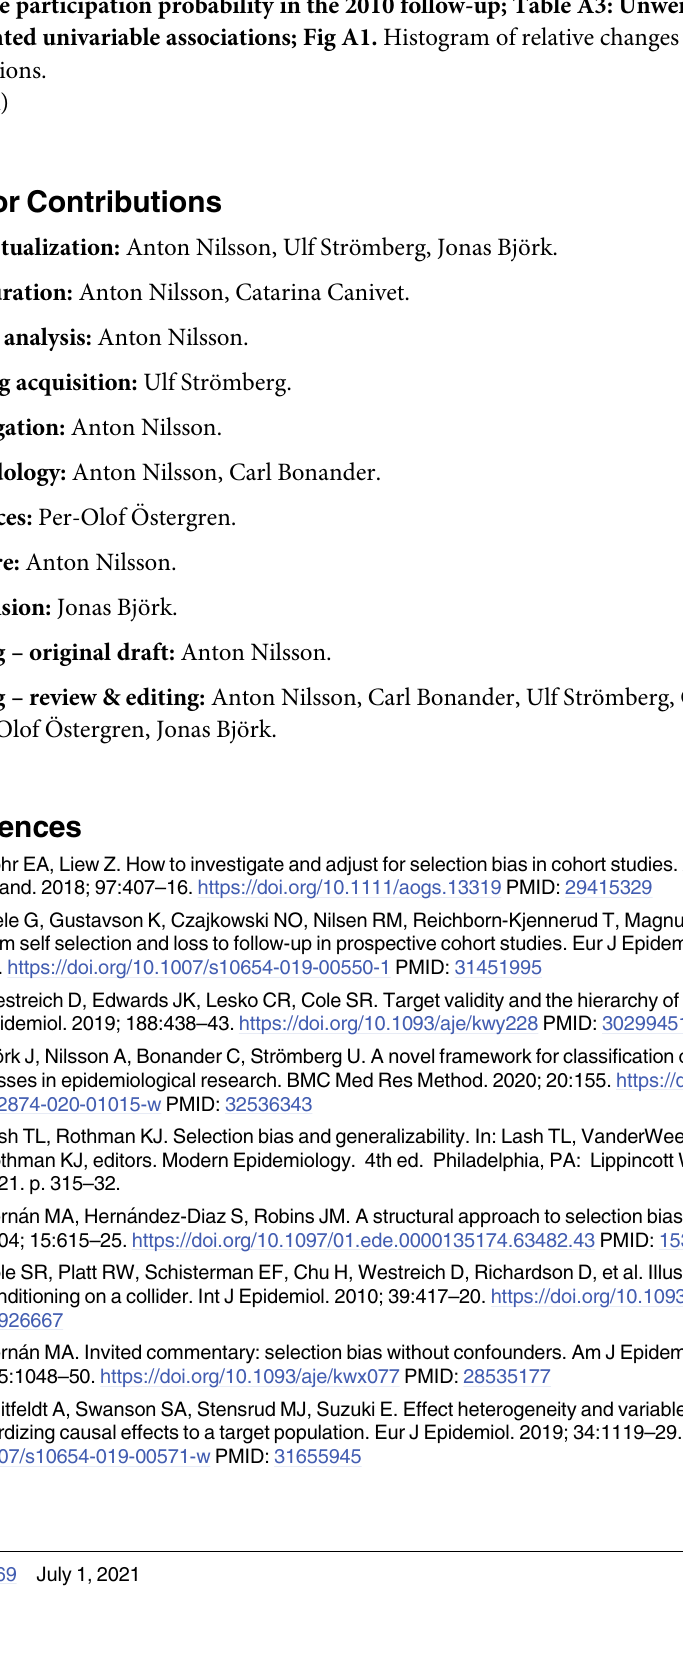
S1 File. Table A1: Background characteristics that were used to estimate participation probability in the 2005 follow-up; Table A2: Background characteristics that were used to estimate participation probability in the 2010 follow-up; Table A3: Unweighted and reweighted univariable associations; Fig A1. Histogram of relative changes in univariable